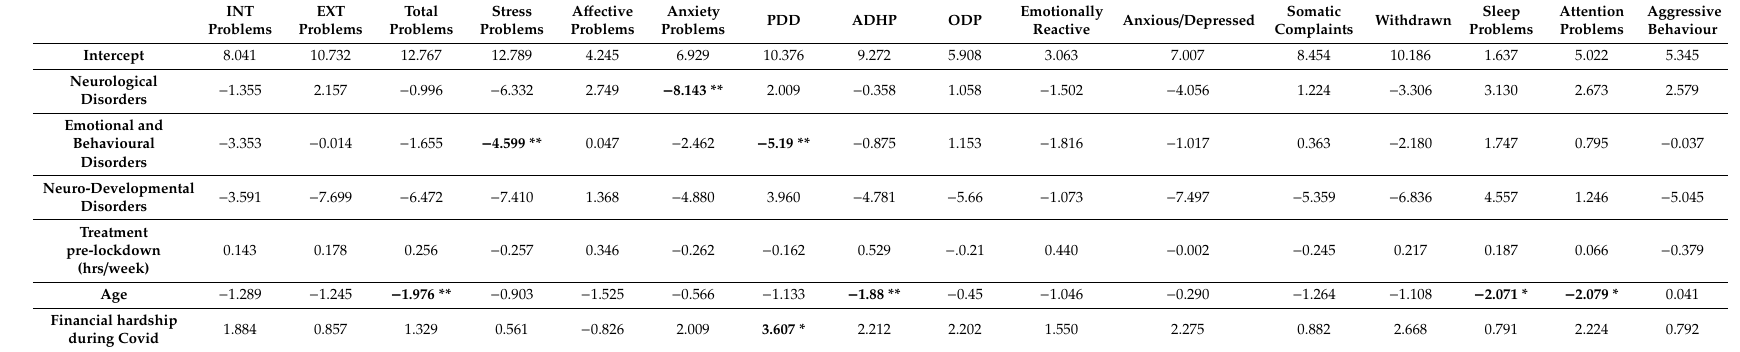
Table 1. Regression models results (1.5–5 years).